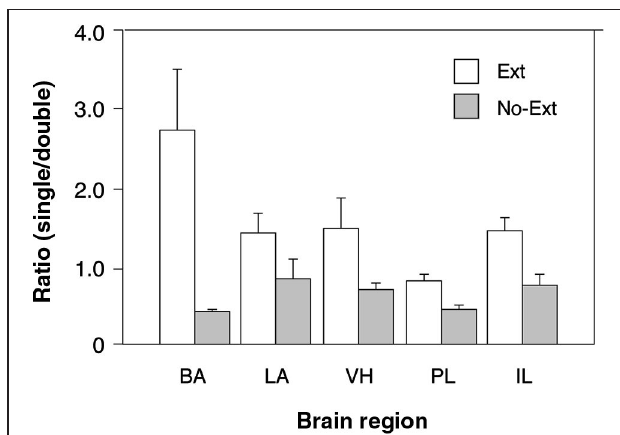
FIGURE 3 | Comparison of the ratio of context-selective to non-selective neurons between extinguished (EXT) and non-extinguished rats (NO-EXT) . Ratios are represented as means ( ± SEM) for the BA, LA, VH, prelimbic cortex (PL), and